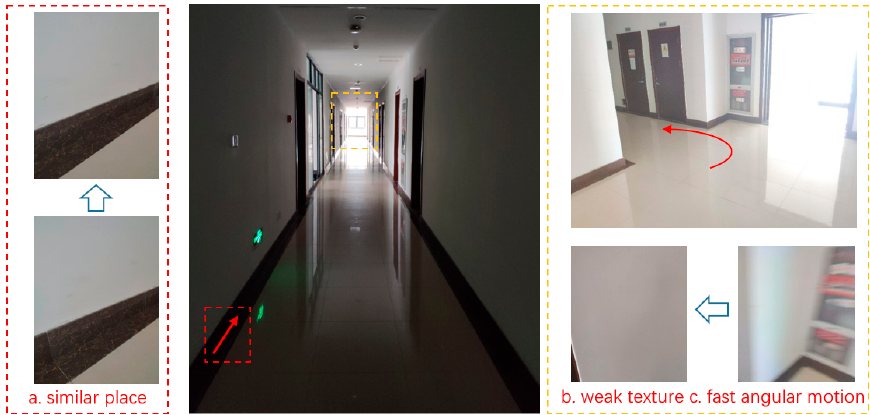
Figure 8. An illustration of the corridor where experiment carried on. Micromachines 2018 , 9 , 626